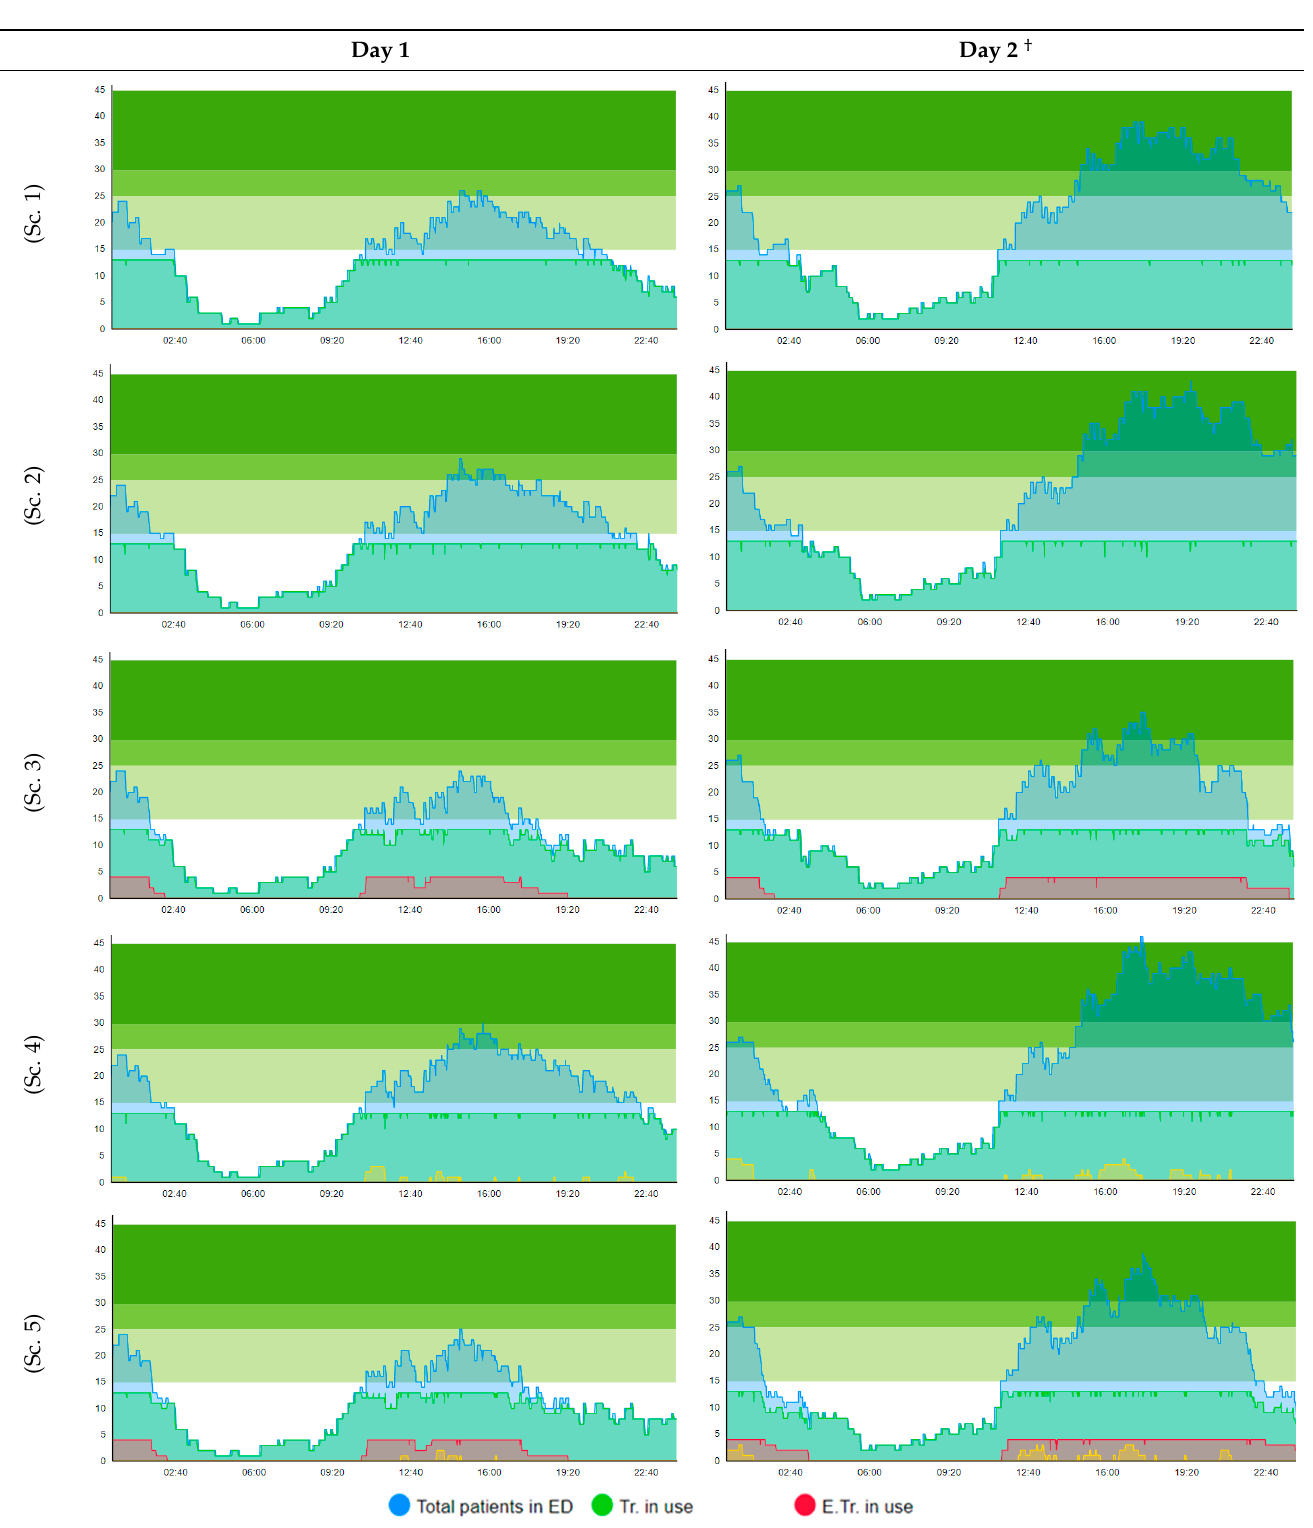
Table A1. Following is a tabulation of all the graphical output produced by running every scenario from 1 until